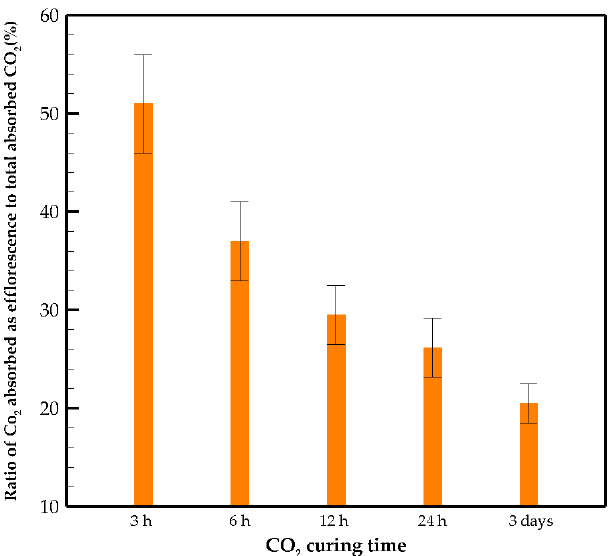
Figure 6. Percentage of CO 2 absorbed as efflorescence with respect to curing